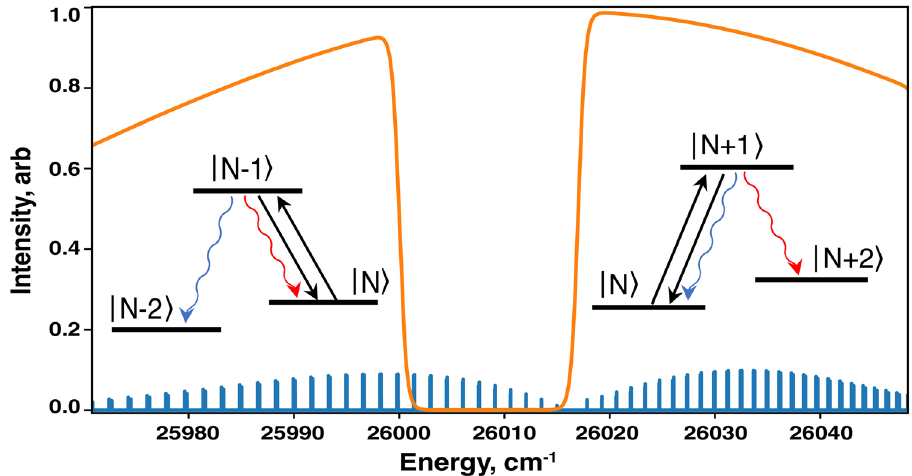
Fig. 6 Optical pumping schematic. Repeated excitations on successive Δ N = + 1 lines (R branch) in the right part of the spectrum accelerate SiO + rotation, while those on Δ N = − 1 (P branch) in the left part of the spectrum decelerate SiO We fi tted to Lorentzian line shapes because our translational temperature was very low due to sympathetic cooling (<1K), and lifetime broadening due to fast dis- sociation of the C state dominated line pro fi les. Doppler broadening at 1K for the SiO + 44,000cm − 1 transition is ~100MHz, and lifetime broadening even for the most stable C, v = 0 level is of order of 1.5GHz. We used PGOPHER for the fi t, which had expressions for line energies and intensities of a 2 Π - 2 Σ transition, and rotational populations were among the fi t parameters along with molecular constants.